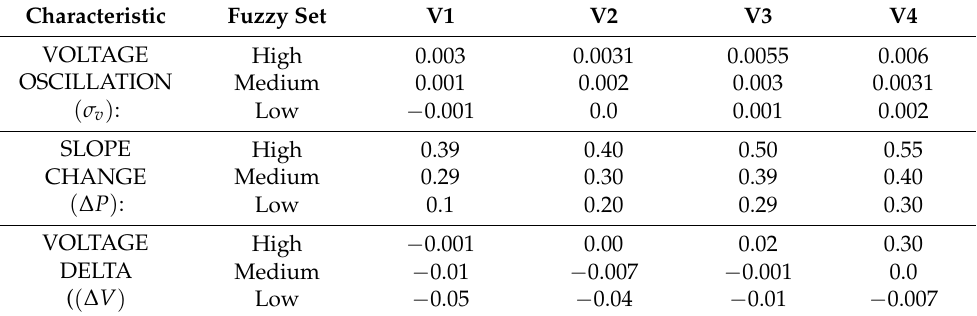
Table 3. Parameter values for each fuzzy set of each of the three characteristics ( ∆ V , σ v , and ∆ P ). Characteristic